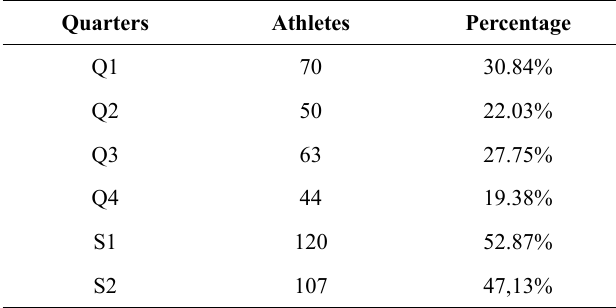
Table 4 – Absolute values for the birthdates of women futsal athletes.